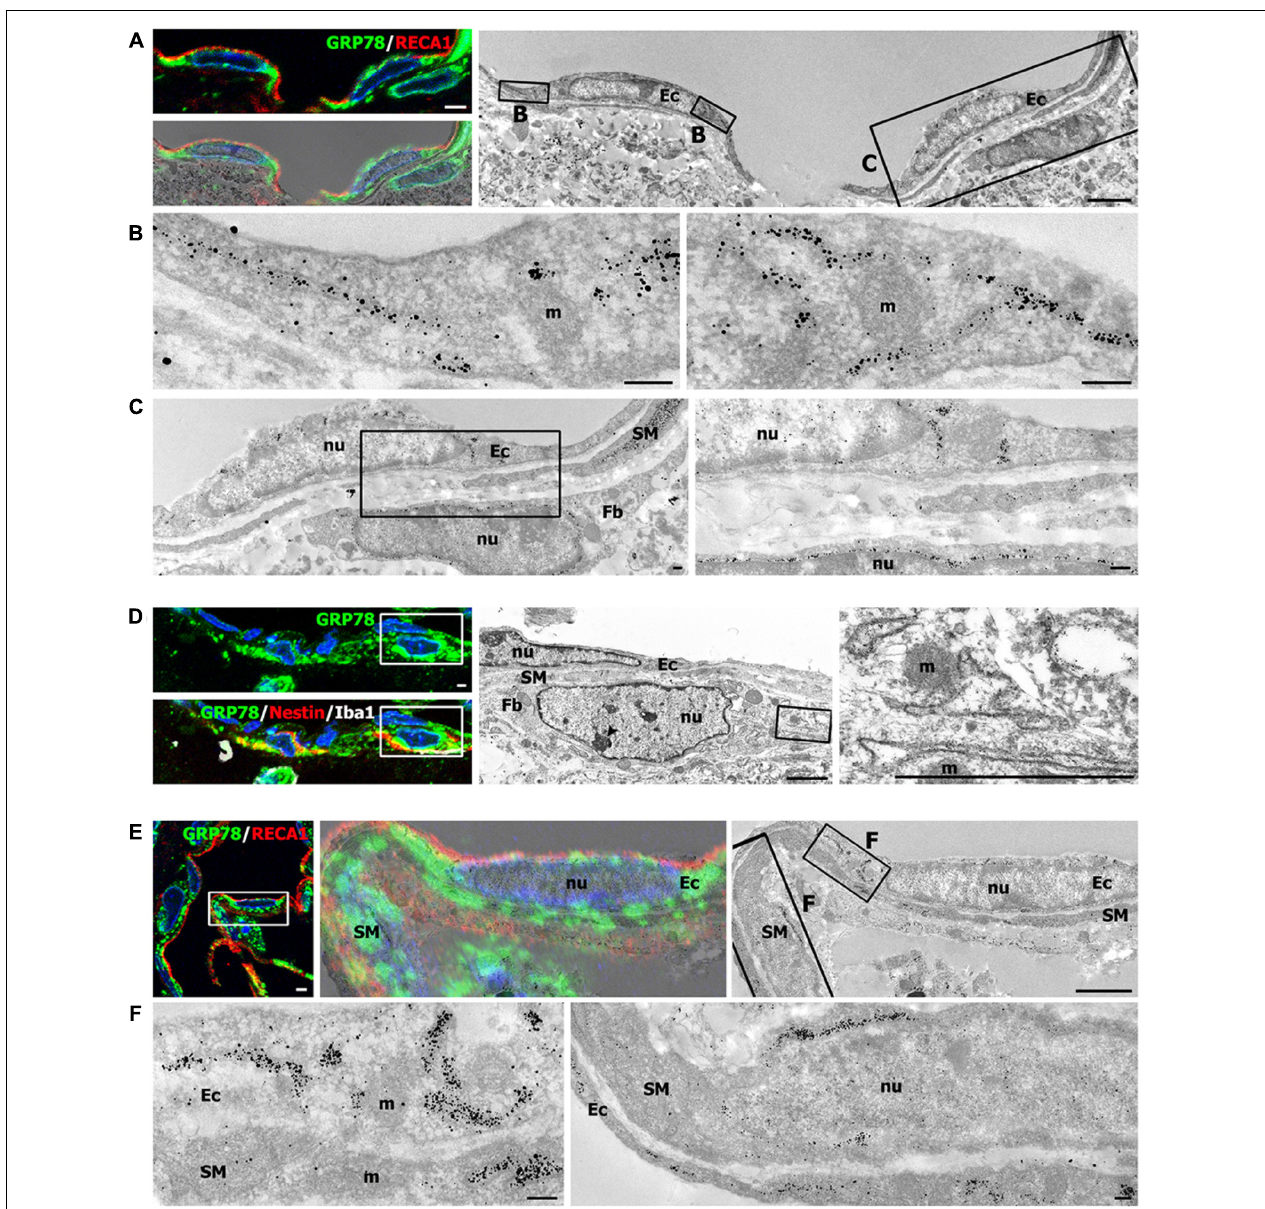
FIGURE 8 | Ultrastructural characterization of vascular glucose-regulated protein (GRP78)-positive cells in the lesion periphery at 3 days after lesion induction by 3-nitropropionic acid injection. (A) Confocal microscopic image of a semi-thin section double-labeled with GRP78 and RECA1 (left upper panel), image of confocal microscopic data overlaid onto the corresponding electron microscopic image (left lower panel), and the corresponding transmission electron microscopic image obtained from the same field (right panel). (B,C) Higher-magnification views of the boxed areas in A . The boxed area in the left panel of C is enlarged in the right panel of C . Notably, GRP78 protein, as indicated by silver-enhanced immunogold particles, is specifically localized to the cisternae of the rough endoplasmic reticulum (rER), but not to other organelles within endothelial cells (Ec), such as mitochondria (m) or nuclei (nu). In addition, GRP78 protein is detectable in perivascular cells (Fb) that are closely apposed to the outer part of endothelial cells and smooth muscle cells (SM). (D) Confocal microscopic image of a semi-thin section triple-labeled for GRP78, Iba1, and nestin (left panel), and the corresponding electron microscopic image of the boxed areas in the left panels (middle panel). The boxed area in the middle panel is enlarged in the right panel. Note that the GRP78/nestin double-labeled cell (Fb) has a large euchromatic nucleus (nu) with prominent nucleolus (arrowhead), and was invariably located outside the endothelial cells (Ec) and smooth muscle cells (SM). Furthermore, GRP78 protein is mainly localized in the rER/perinuclear cisternae, but not in the mitochondria (m) or nucleus (nu) of GRP78/nestin double-labeled cells. (E) Confocal microscopic image of a semi-thin section double-labeled for GRP78 and RECA1 (left panel), the corresponding transmission electron microscopic image of the boxed area in the left panel (right panel), and their overlay image (middle panel). (F) Higher-magnification images of the boxed areas in the right panel of E . Notably, the silver-enhanced immunogold particles targeted to GRP78 are specifically associated with the perinuclear cistern and the cisternae of the rER of endothelial cells (Ec) and smooth muscle cells (SM), but not with mitochondria (m). Cell nuclei are stained with 4 (cid:48) ,6-diamidino-2-phenylindole. Scale bars represent 2 µ m for A , D , E ; 1 µ m for C ; and 0.2 µ m for B , F .